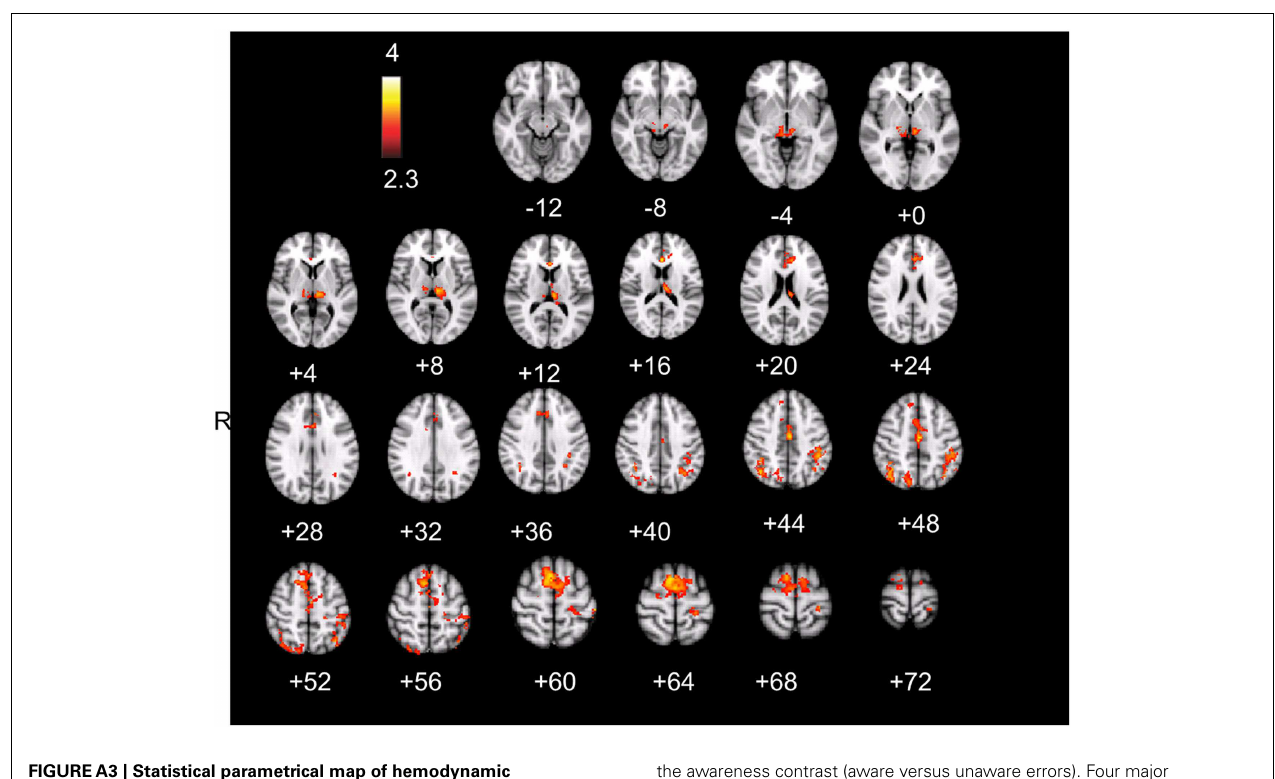
FIGUREA3 | Statistical parametrical map of hemodynamic response varying in each individual with aware errors and with the interval effect on target detection. Red and yellow voxels represent clusters of significant BOLD signal which passed the thresholding in the target interval contrast (ITI3–ITI1) and also survived thresholding in